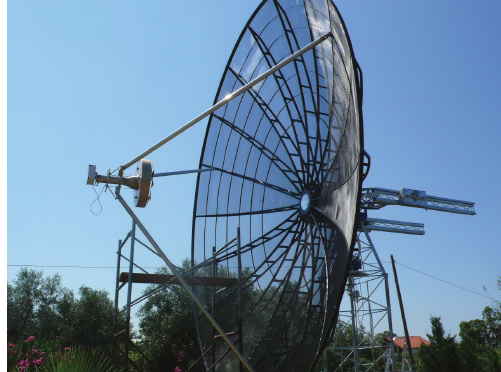
Figure 15: Prototype of the feed mounted on antenna during Sun noise